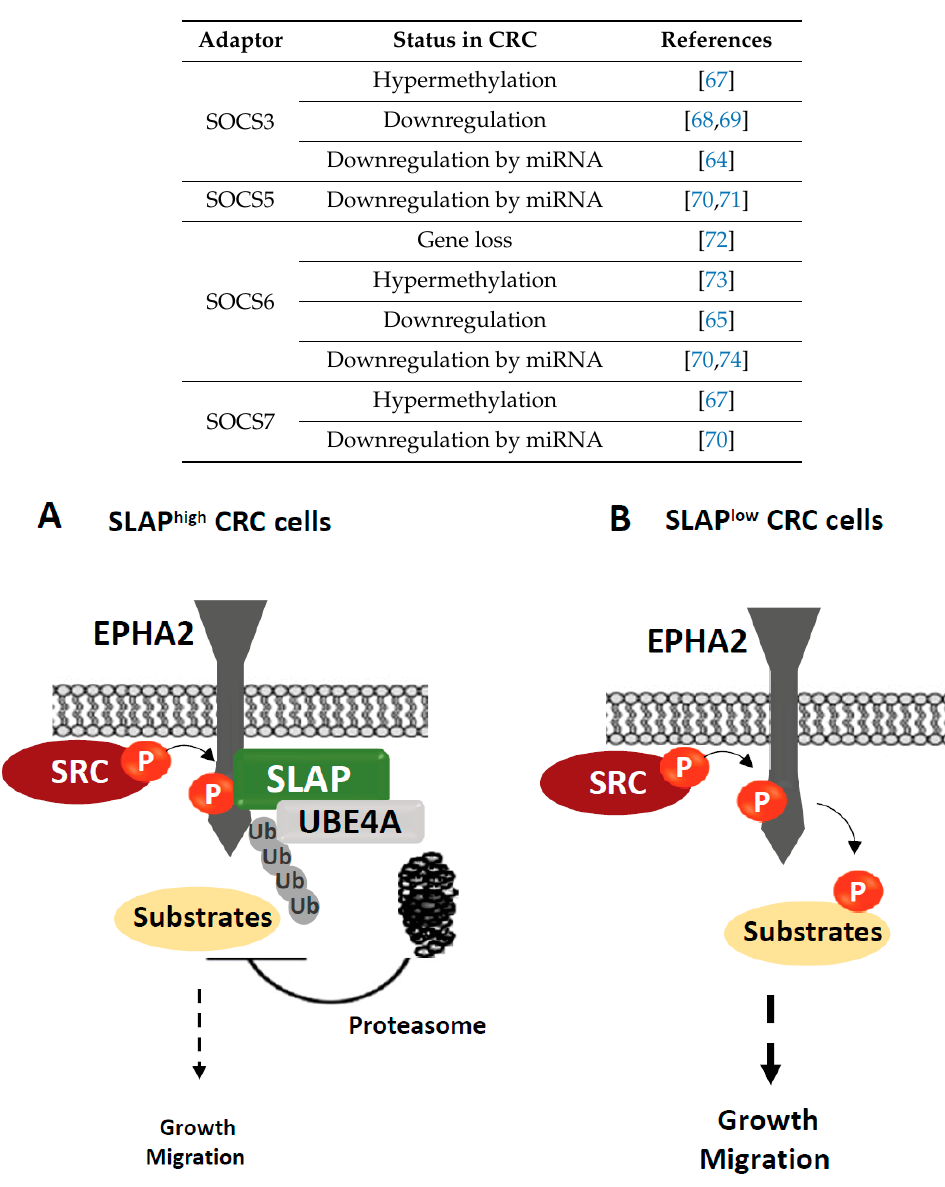
Figure 3. Model depicting how SLAP counteracts SRC signalling in CRC cells. ( A ) In CRC cells